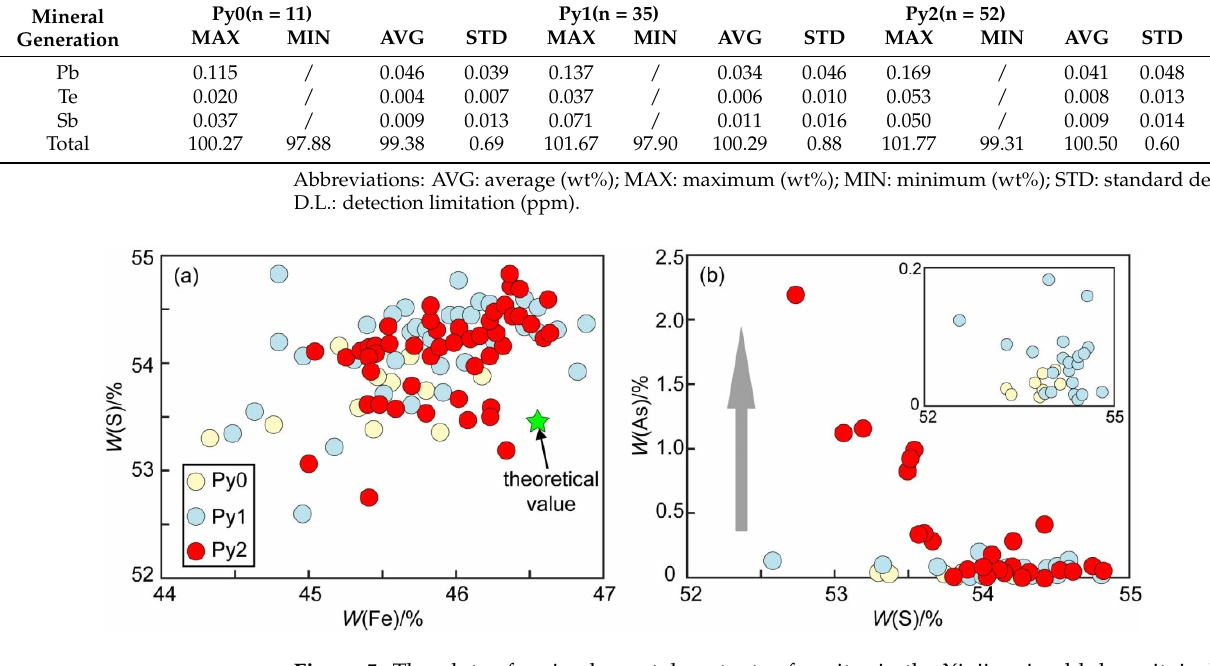
Table 2. Sulfur isotopic composition of pyrite from the Xinjiazui, Dingjialin, and Taiyangping gold